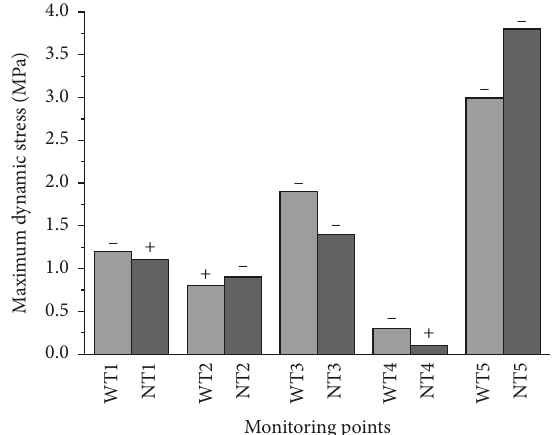
Figure 7: Maximum dynamic stress value of each monitoring point.